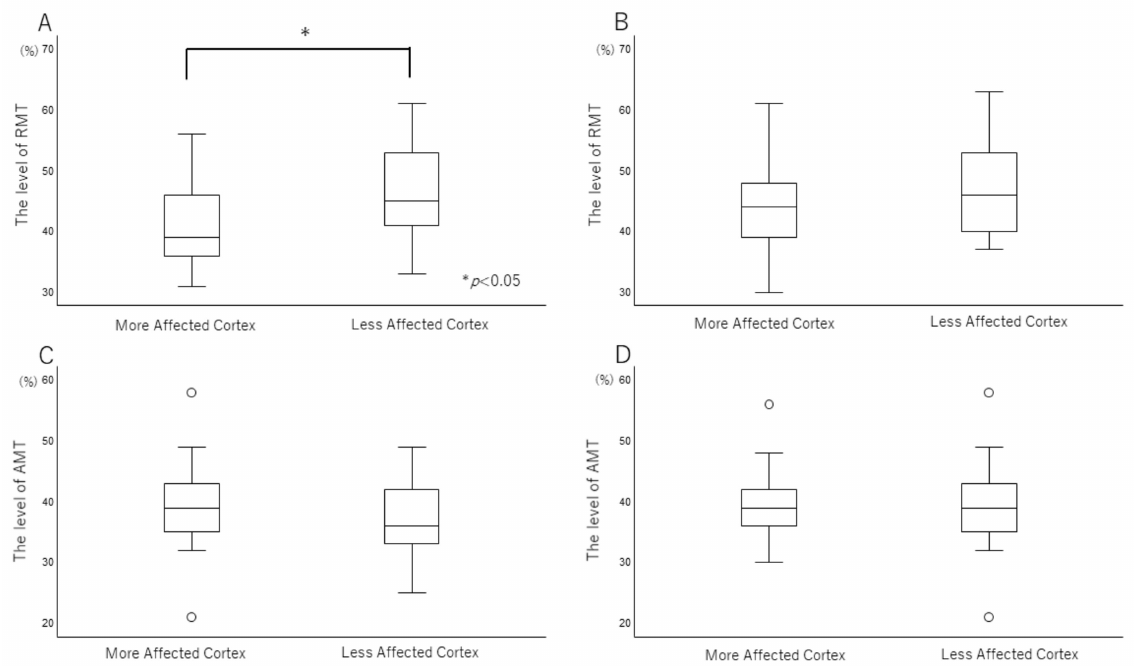
Figure 1. The comparison between more affected side and less affected side. ( A , C ) OFF period, ( B , D ) ON period. The levels of the RMT in the more affected side were significantly lower than those in the less affected side in OFF state ( p < 0.01). Median values are represented by a thick black horizontal line within the box, and the box represents the upper and lower quartiles. The whiskers represent the maximum and minimum values, excluding outliers, which are shown as small circles, at least 1.5 times the interquartile